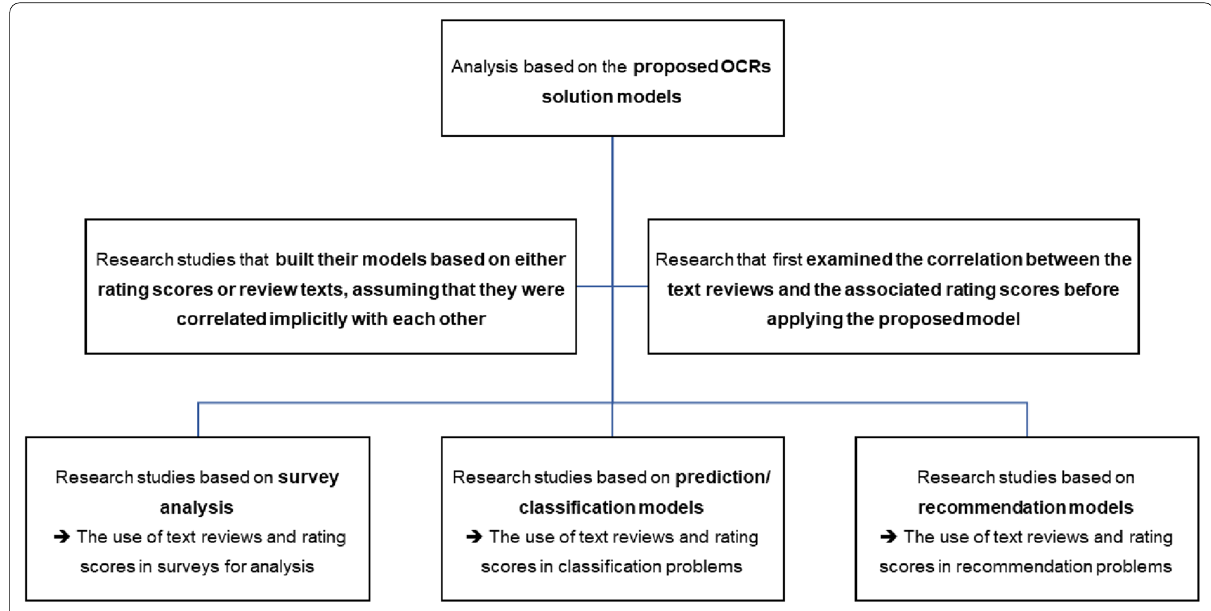
Fig. 3 Framework adopted for conducting the